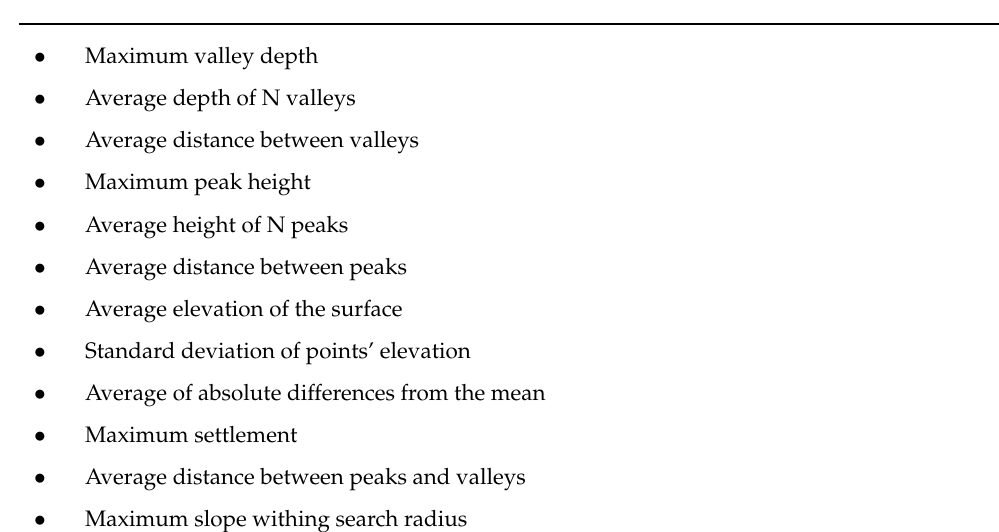
Table 1. Differential settlement